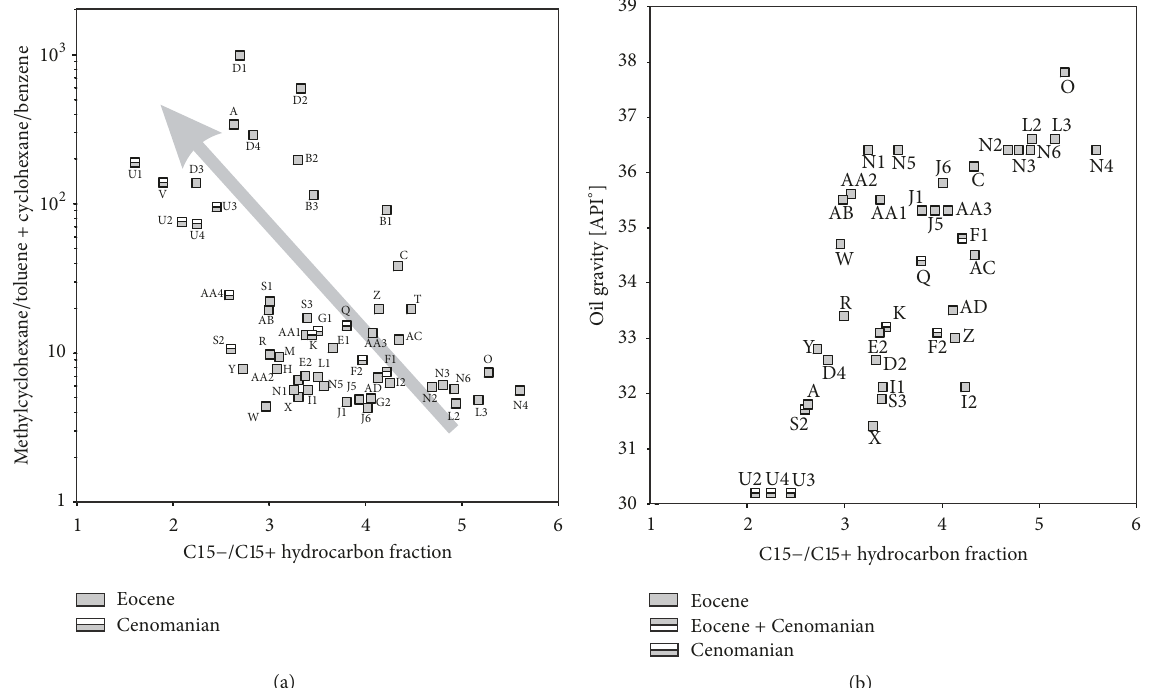
Figure 9: Cross-plots of the ratio of the sum of hydrocarbons with less than 15 carbon atoms over the sum of hydrocarbons with more than 15 carbon atoms (C 15− /C 15+ ) versus (a) the sum of two ratios between cycloalkanes and aromatic hydrocarbons and (b) API oil gravity. Grey arrow indicates effect of water washing. For sample location, see Figure 1(c).